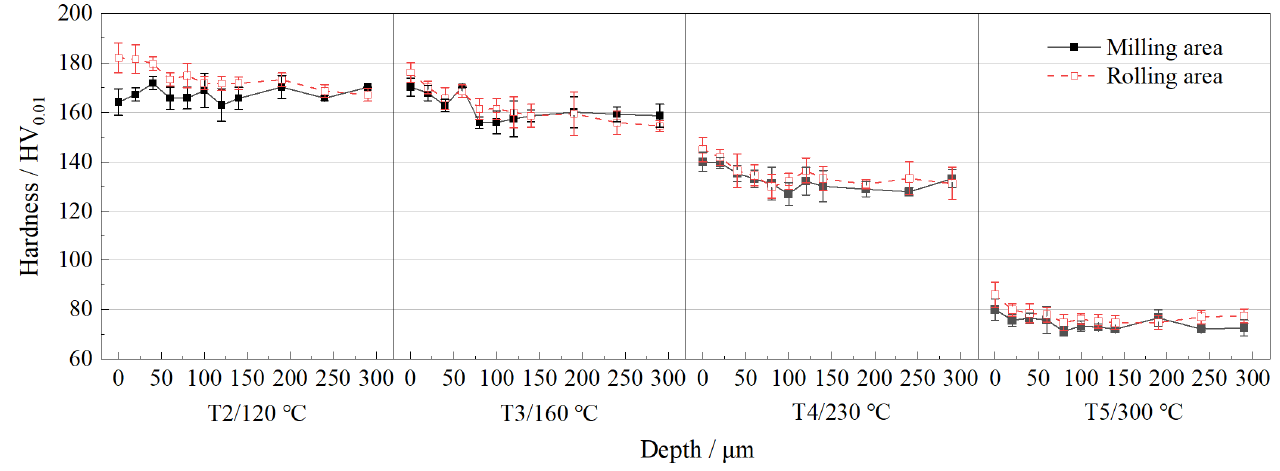
Figure 8. Microhardness distribution along the depth direction after different thermal loads.